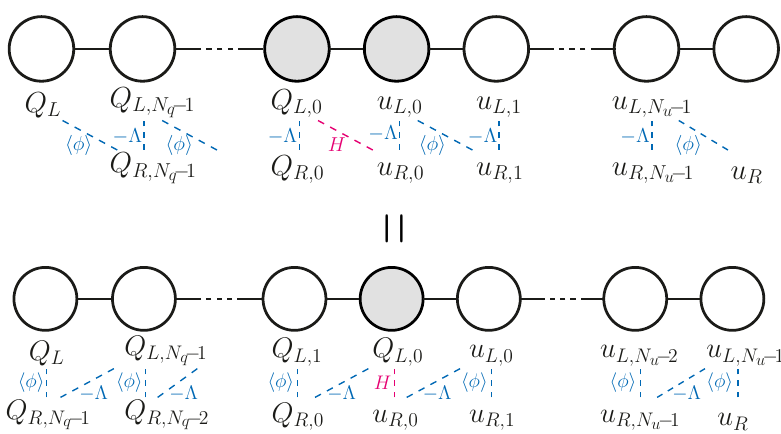
Figure 6 . Top: the traditional FN chain with the (cid:12)elds on the same node carrying the same U(1) H horizontal (and electroweak) charges. The chiral (cid:12)elds on the outermost nodes are charged under U(1) H . Bottom: re-grouping into two clockwork chains connected through a Higgs Yukawa interaction on the middle node after (cid:13)avon obtains a vev, interactions